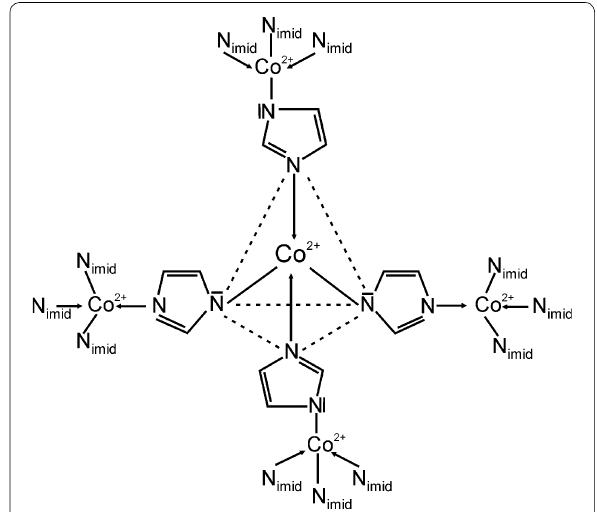
Fig. 1 Schematic structure of the polymeric [Co(imid) 2 ] n